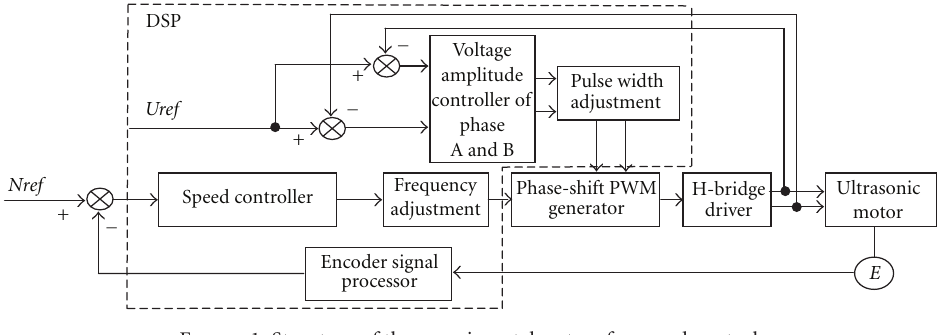
Figure 1: Structure of the experimental system for speed control.